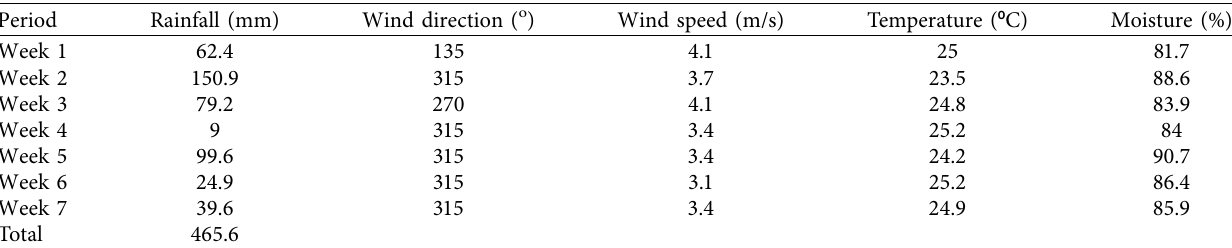
Figure 3: The appearance of erosion plots in the field at preparatory conditions. (a) Erosion zone. (b) Deposition zone. Table 1: Climate conditions in the study area.